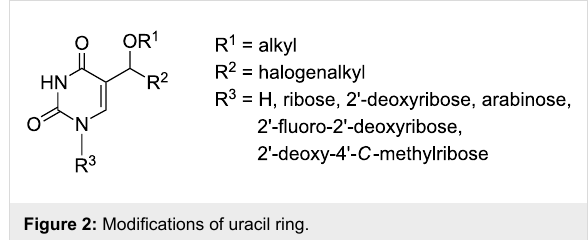
Figure 2: Modifications of uracil ring.